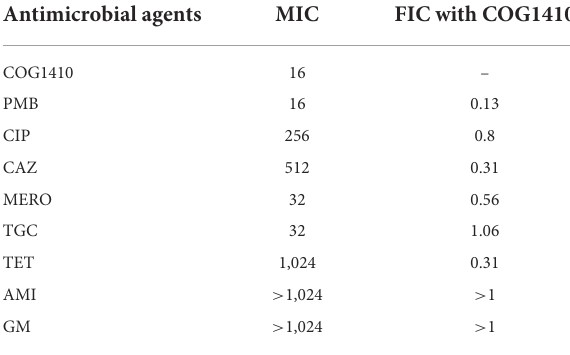
TABLE 2 Fractional inhibitory concentrations of COG1410 and different antibiotics against the PDR A. baumannii strain YQ4. Antimicrobial agents